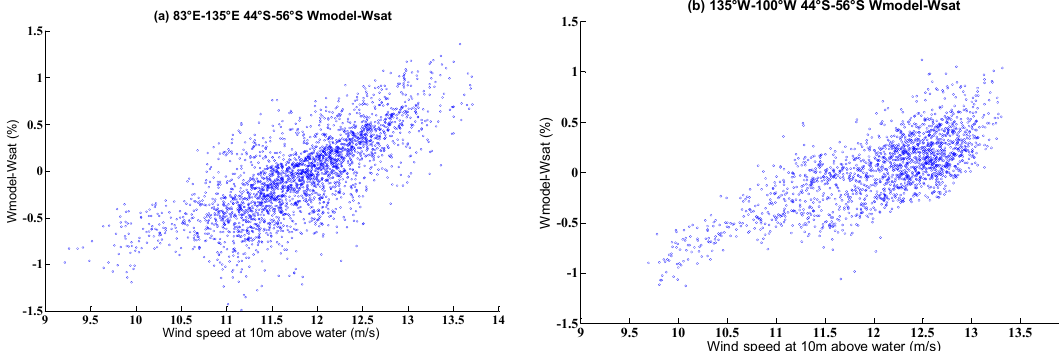
Table 6. Maximum and mean whitecap coverage over the eastern part (83° E–135° E, 44° S– 56° S).